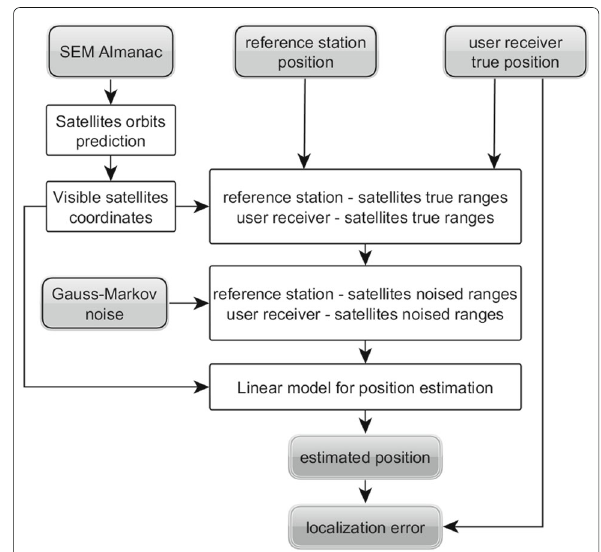
Fig. 9 Block scheme illustrating simulation environment for the RTK positioning error